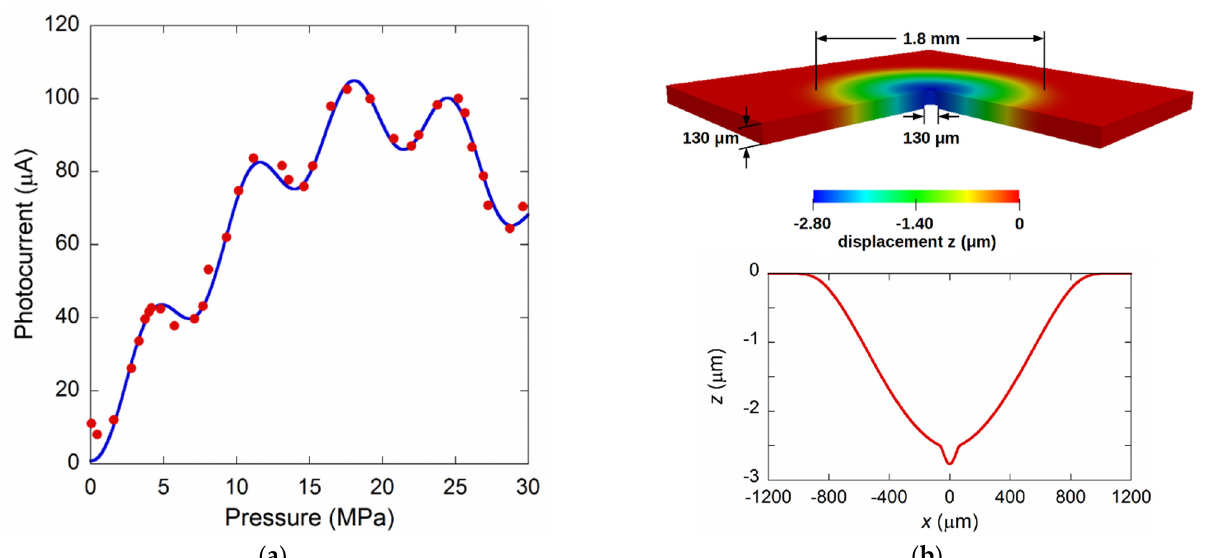
Figure 13. ( a ) Photocurrent signal acquired for a membrane sensor with a diameter of 130 μ m. The continuous blue line represents best fit of data obtained considering the superposition of both the silicon and diamond displacement, according to Equation (9). ( b ) Numerical simulation of the structure in which the silicon substrate was considered unbounded on a circle of 1.8 mm diameter.